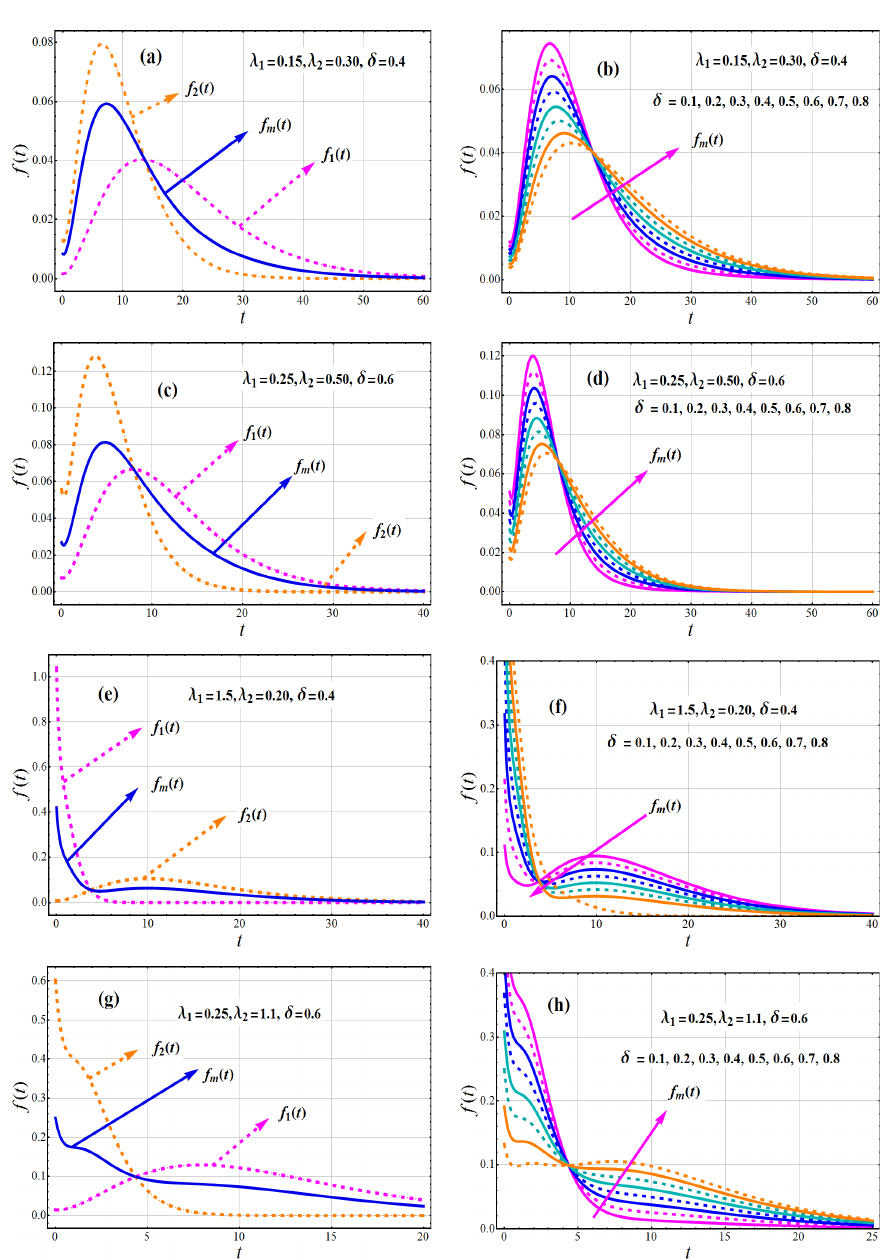
Figure 1. Behavior of f 1 ( t | λ 1 ) (first component density), f 2 ( t | λ 2 ) (second component density) and Fig. 1. Behaviour of f density of TC-MAM f m ( t | (cid:118) ) with δ against t